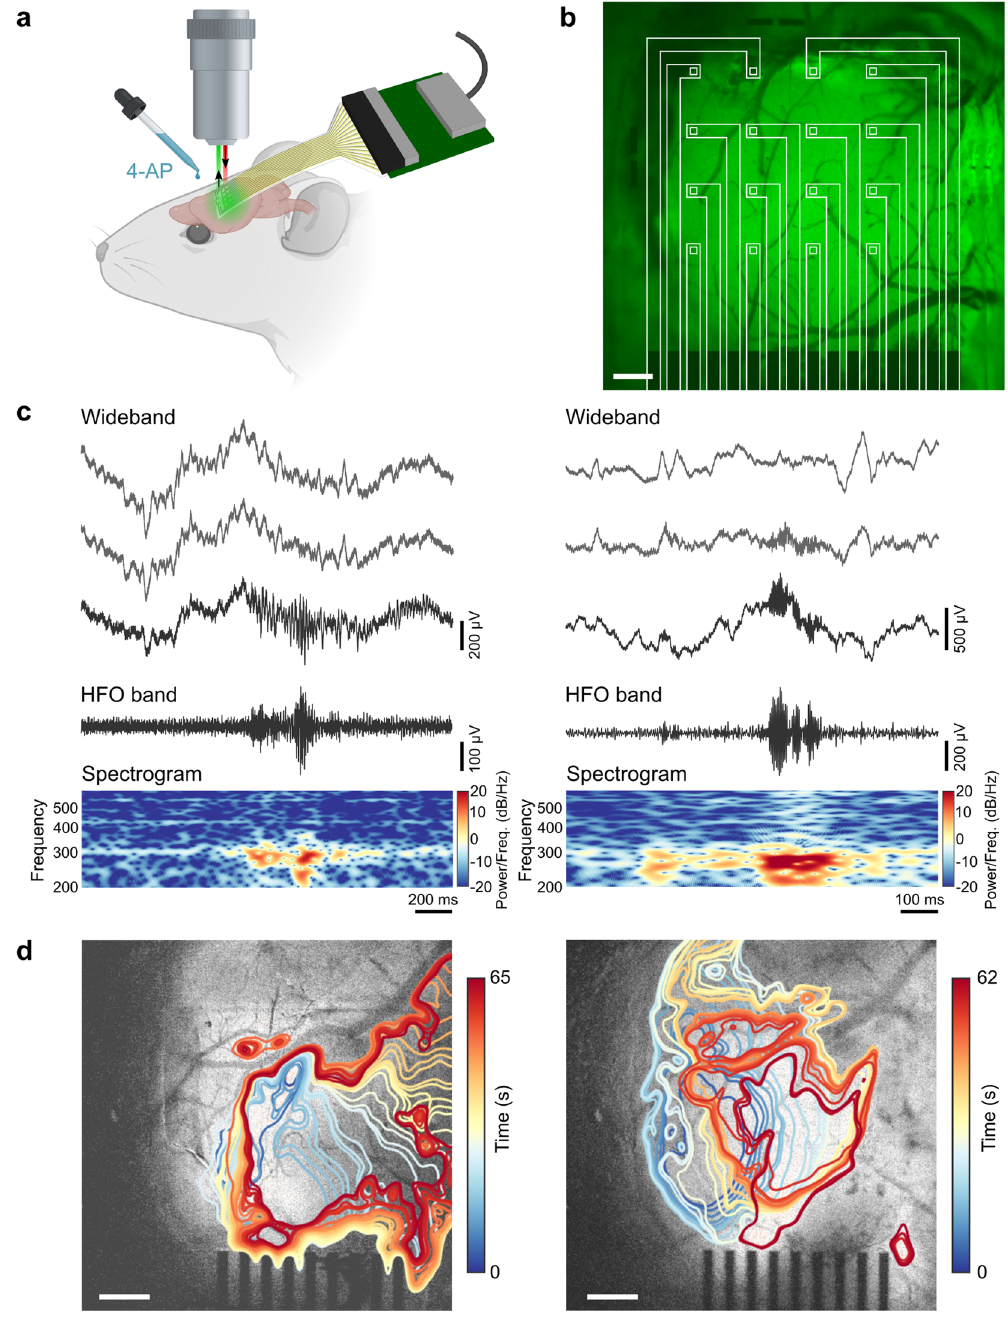
Fig. 2 Simultaneous electrophysiology and calcium imaging of 4-AP-induced seizure activity in an anesthetized mouse. a Schematic of the in vivo recording and imaging setup. Image created with BioRender.com. b Image of the graphene electrode array placed over barrel cortex, with baseline calcium epi fl uorescence visible in green, and array outlined in white to show locations of the electrodes. Scale bar: 300 μ m. c Examples of two clinician-validated high-frequency oscillations (HFOs) recorded on graphene electrodes. Raw, wideband signal from three adjacent electrodes highlights the localized nature of the HFOs. Below these, the 80 – 600 Hz bandpass- fi ltered signal and the spectrogram, which reveals 200 – 300 Hz power consistent with fast-ripple HFOs, are shown for the bottom-most wideband signal trace. d Two representative examples of ictal wavefront onset and propagation patterns observed in the calcium epi fl uorescence imaging for different seizure events, showing complex non-stereotyped spatial patterns of activation and spread. Ictal wavefront progression is overlaid on images of baseline fl uorescence. Scale bars: 500 μ